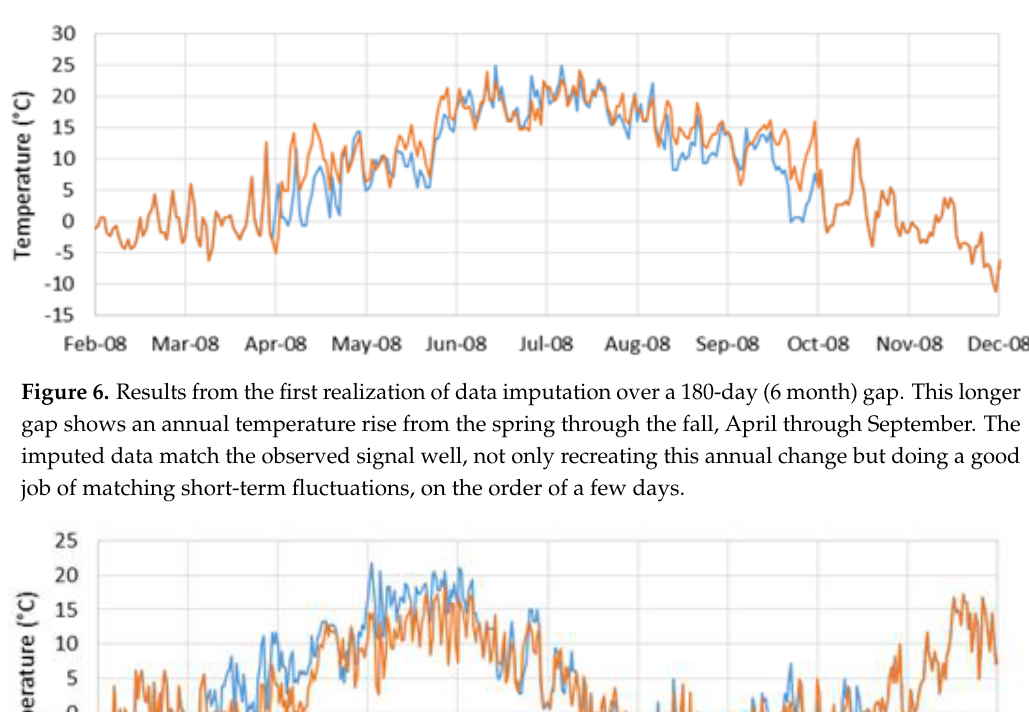
Figure 5. Results from the first realization of data imputation over a 30-day gap. In this figure, the orange line are the observed data and the blue line are the imputed data. Visually the imputed data match the general trends and values of the observed data.